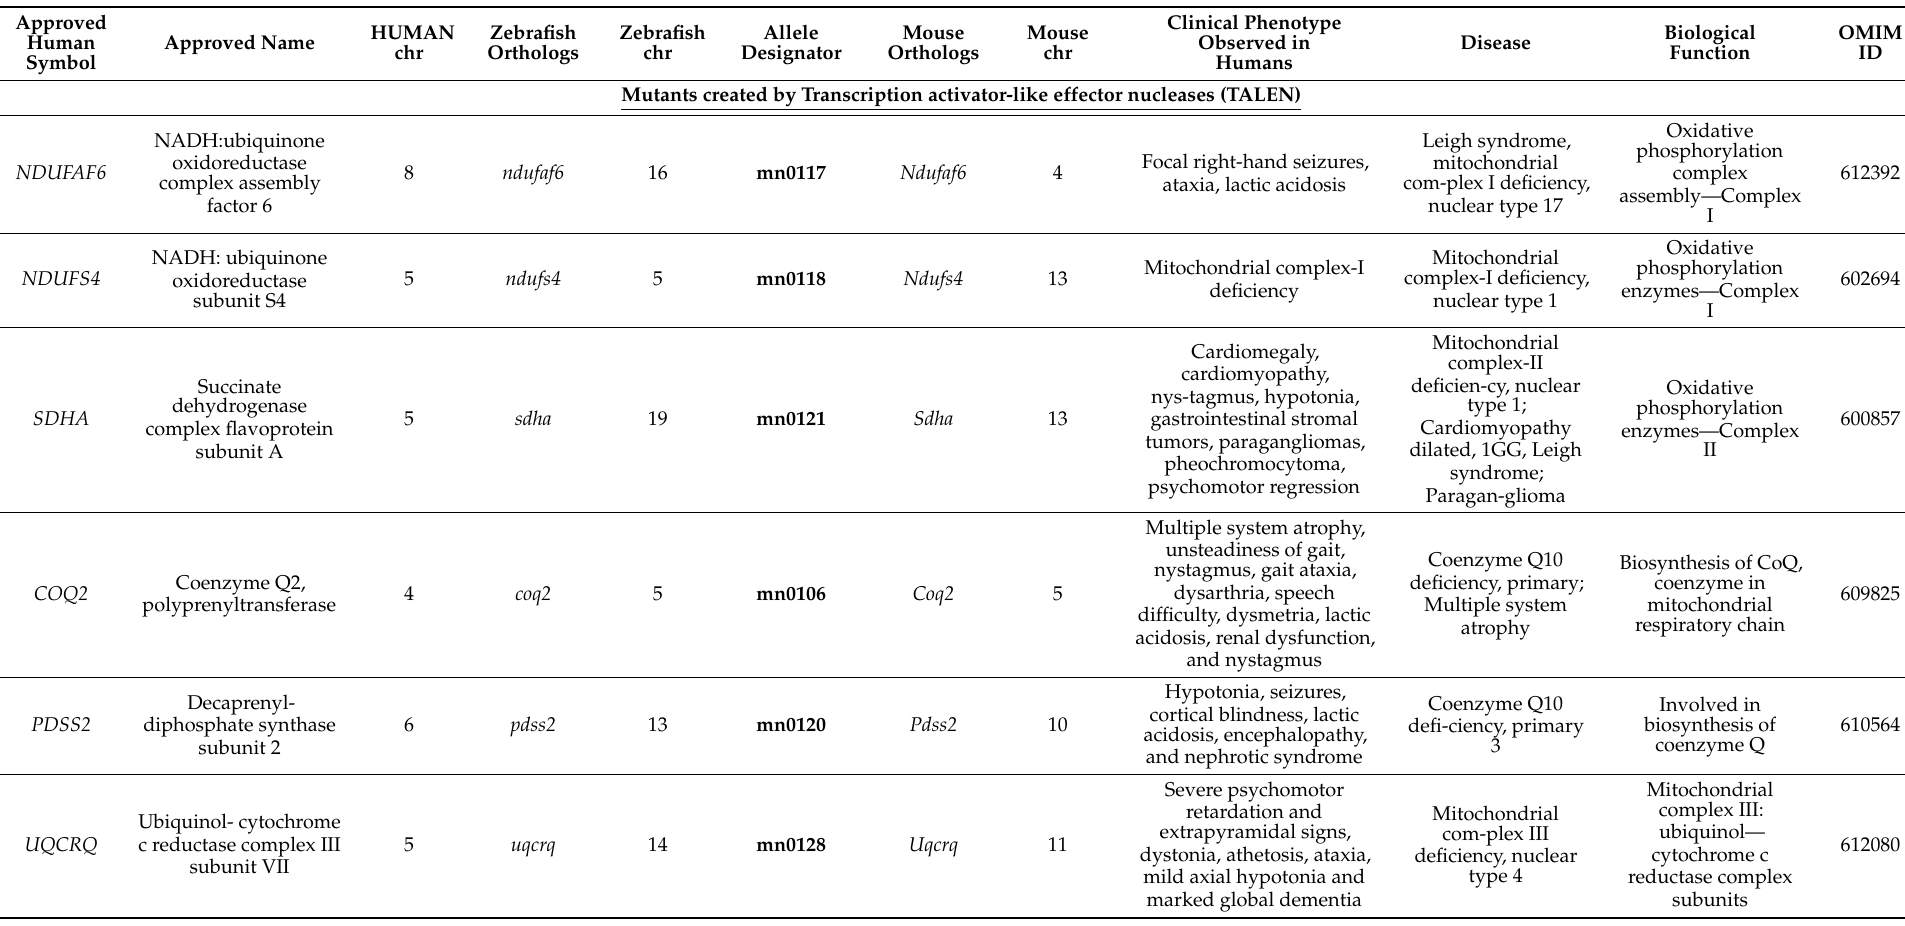
Table 1. List of nuclear-encoded genes for which zebrafish mutants were generated as part of MMC collection: The current MMC resource list summarizes information on the human gene, zebrafish ortholog, mouse ortholog, relevant clinical phenotypes and diseases, protein function, and OMIM ID. Allele designators are highlighted in bold for respective zebrafish paralog. (chr—Chromosome; OMIM ID—Online Mendelian Inheritance in Man ID; n/a—not available) (mn1104gt and mn0582 are candidate lines